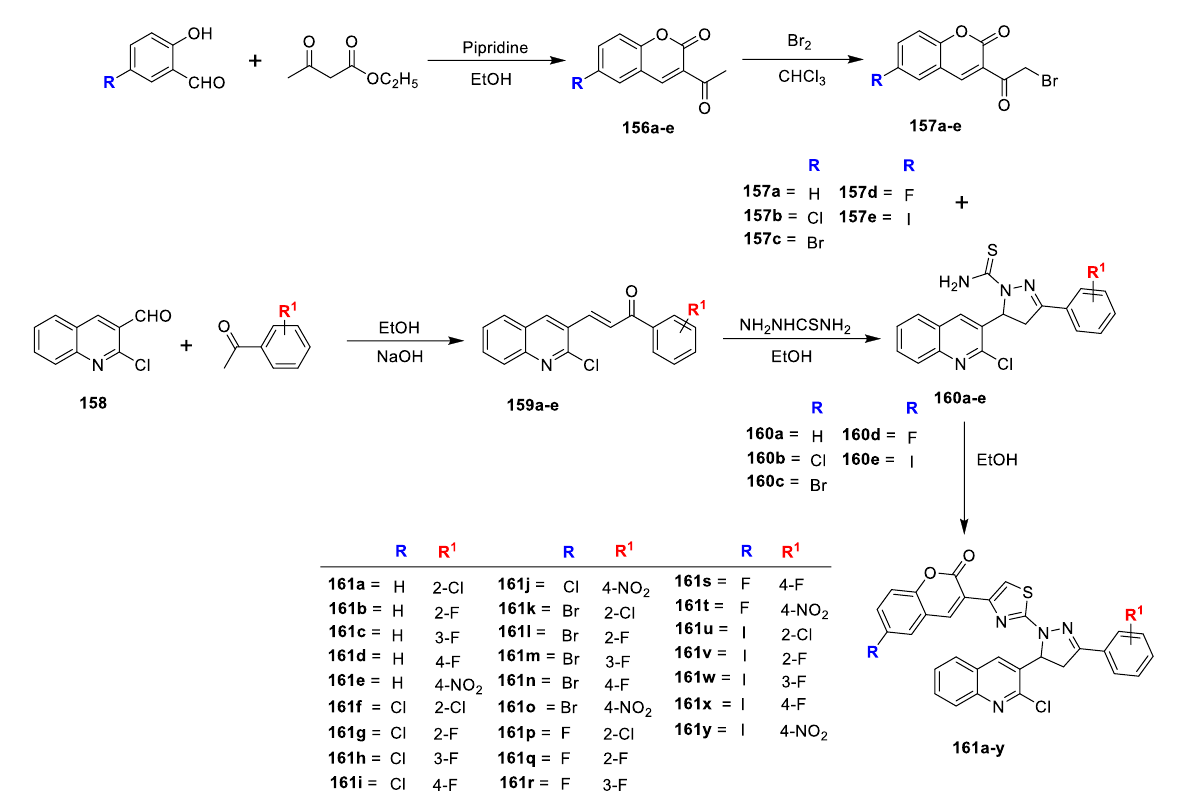
Scheme 34 . Systematic representation for synthesis of derivatives 161a – y . Reproduced and adapted Scheme 34. Systematic representation for synthesis of derivatives 161a–y . Reproduced and adapted with permission from ref. 50. Copyright 2017, Springer Nature. with permission from Ref. [50]. Copyright 2017, Springer